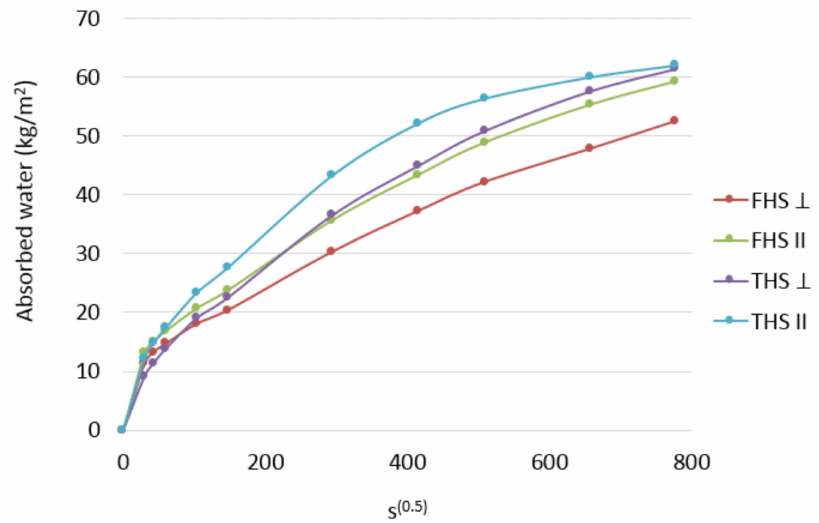
Figure 6. Capillary uptake of the tested